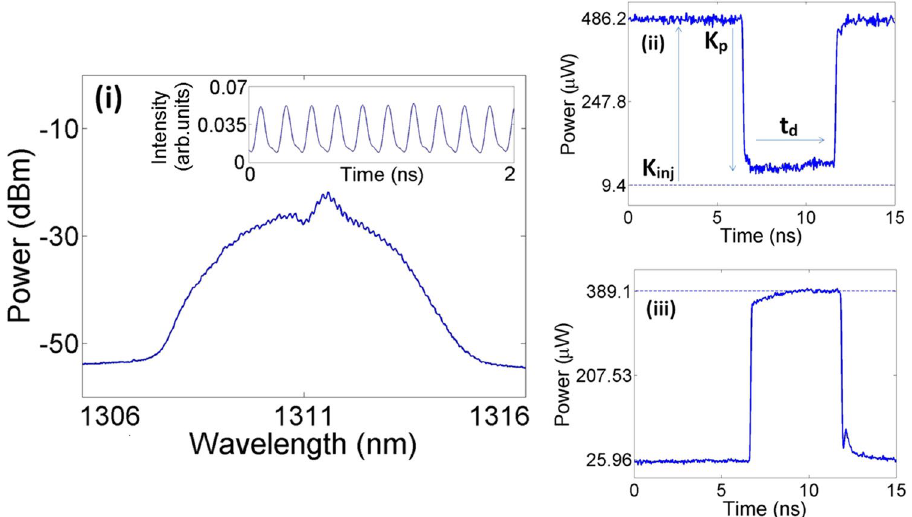
Figure 2. (i) Spectrum and time series of the solitary QDMLL with the device biased at 77.3 mA (gain section), − 2.5 V (absorber section) and at 293 K. Time traces of a negative (ii) and a positive (iii) temporal perturbation used respectively to controllably activate and inhibit the mode-locked pulsating devices. (ii) K = 0.943 and